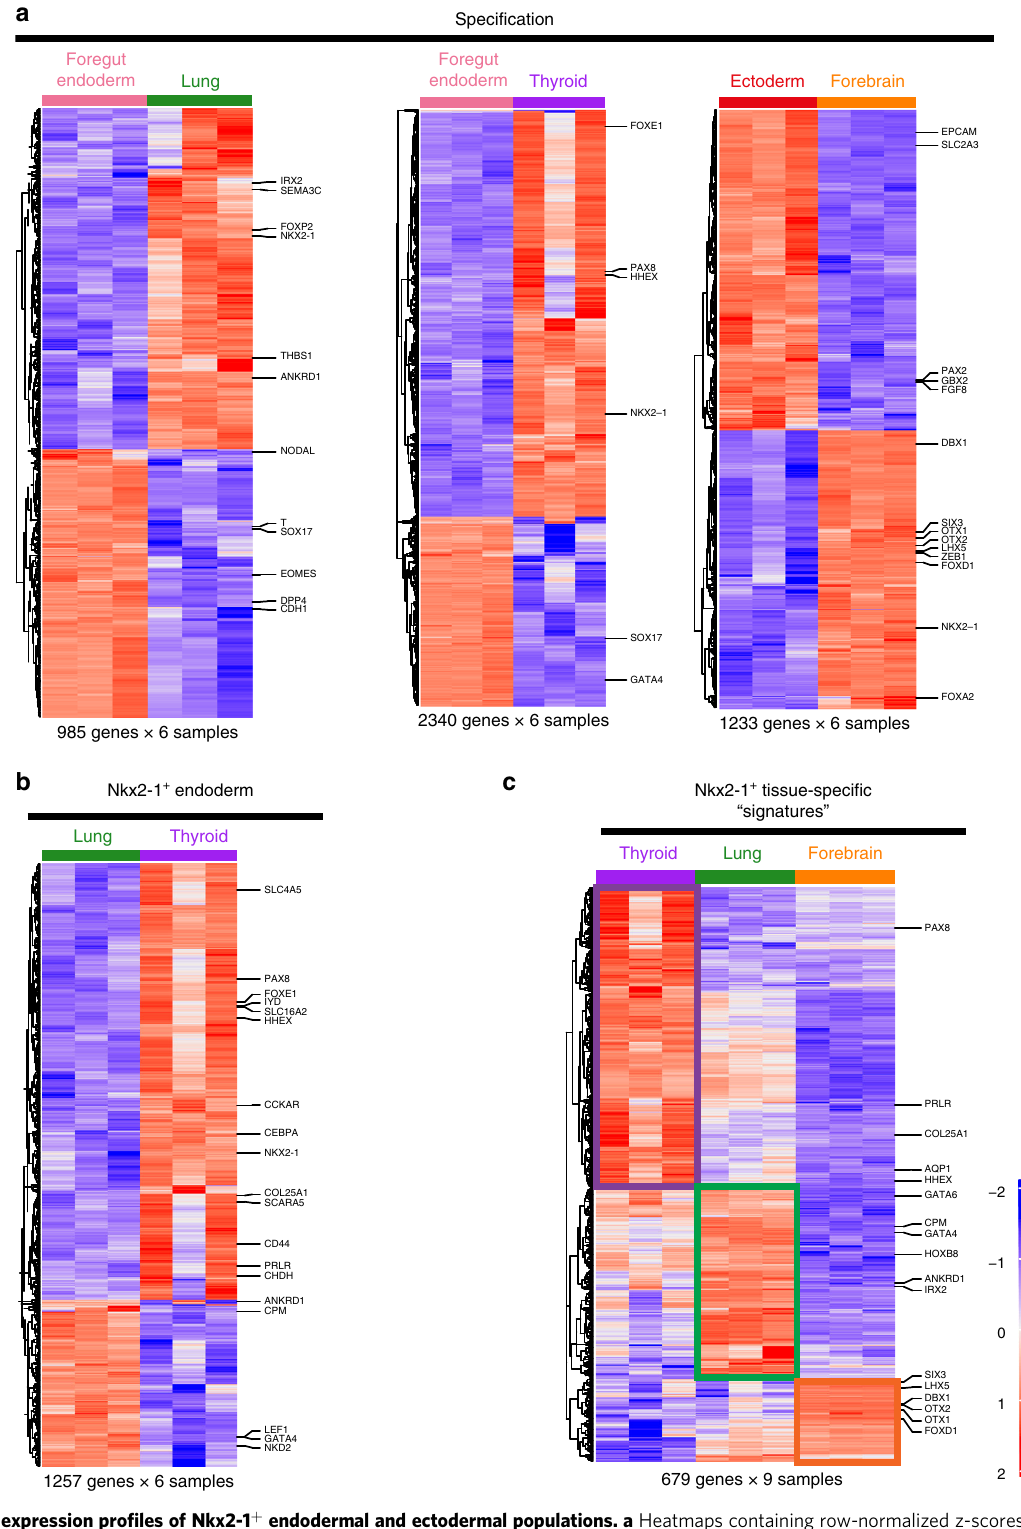
Fig. 3 Gene expression pro fi les of Nkx2-1 + endodermal and ectodermal populations. a Heatmaps containing row-normalized z-scores and representing unsupervised hierarchical clustering of samples analyzed in population RNA-Seq. Each heatmap depicts the pairwise comparison of speci fi ed endodermal or ectodermal Nkx2-1 + populations and their precursor stage (foregut endoderm and ectoderm, respectively). The number of genes used to create each heatmap appears underneath the heatmap. The cutoff criteria used de fi ne the number of genes for each heatmap are: false discovery rate (FDR) < 0.05, average expression > 0 and |log 2 (fold change)| > 2. b Heatmap of differentially expressed transcripts between the two Nkx2-1 + endodermal progenitor cell populations (lung and thyroid). The same cutoff criteria as in ( a ) were used. c Heatmap of differentially expressed transcripts across the three Nkx2-1 + cell populations (tissue-speci fi c gene “ signatures ” ). The same cutoff criteria as in ( a ) were used with the only difference of |log 2 (fold change)| >